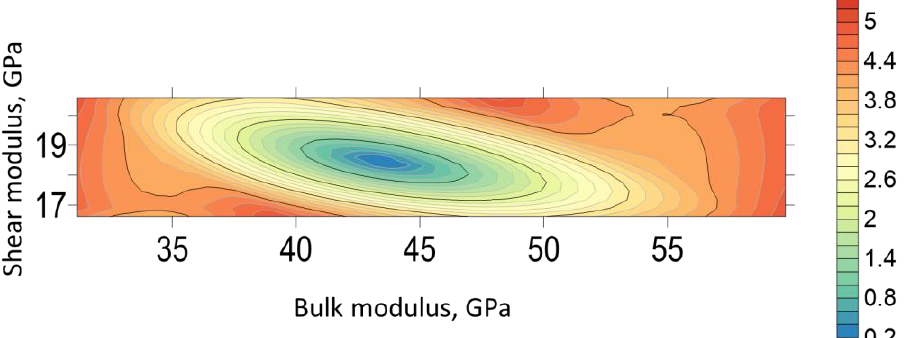
Figure 15. Surfaces of characteristic Discrepancy measure (%) versus elastic moduli of the host matrix for Sample 1.